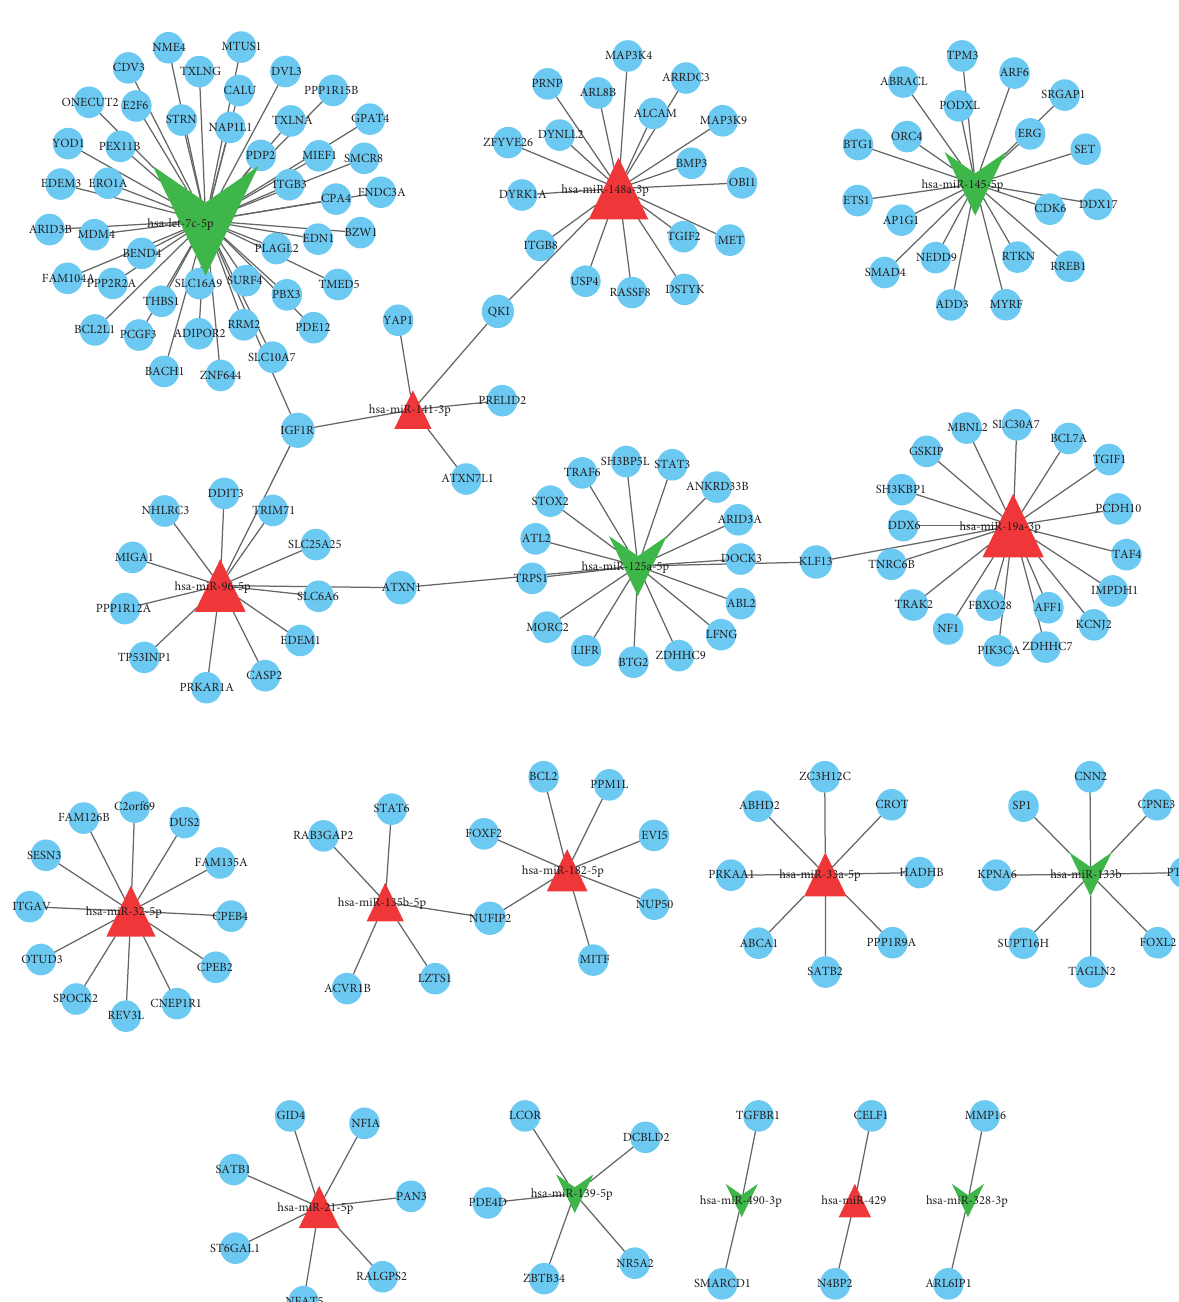
Figure 3: MiRNA-target gene regulatory network. Te red triangle represents the upregulated miRNAs, the green arrow represents the downregulated miRNAs, and the blue circle represents the target genes. A bigger node size indicates a higher